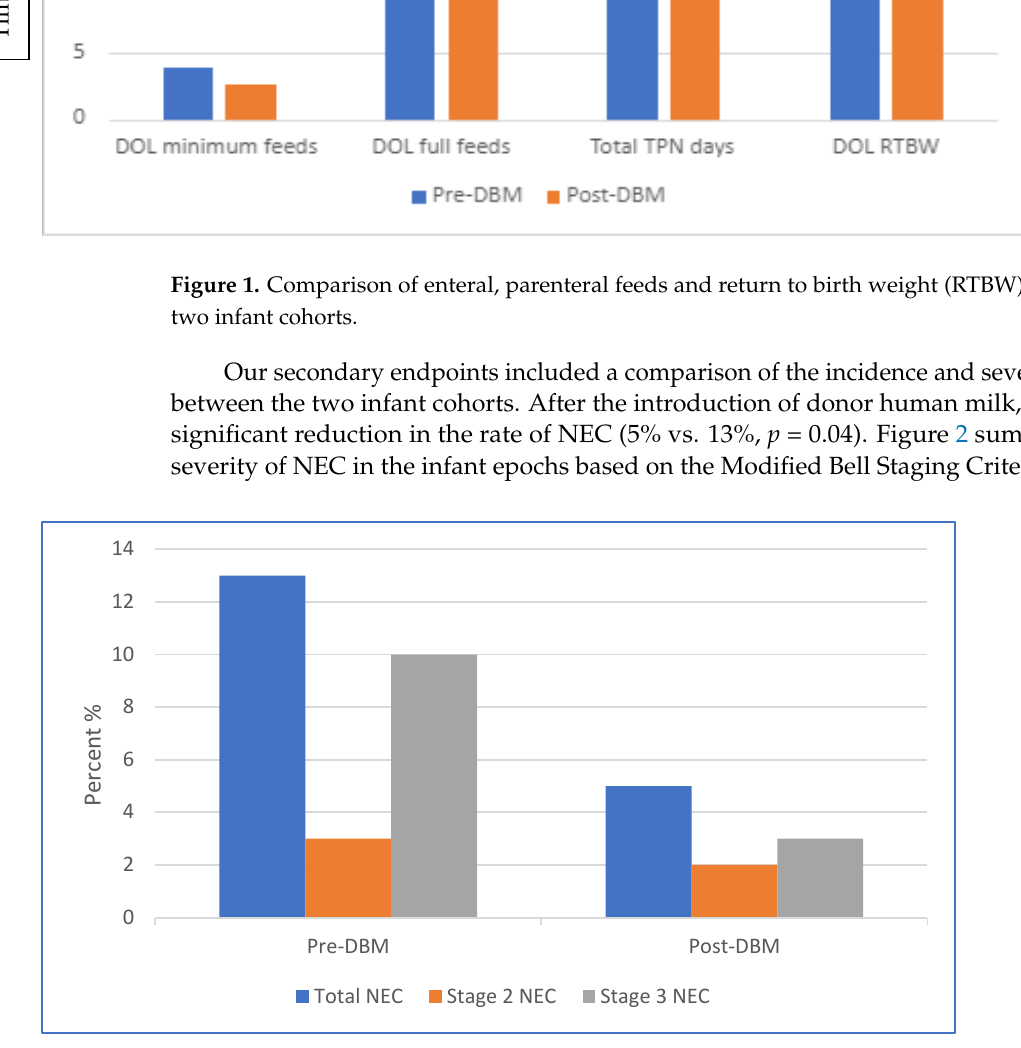
Figure 1. Comparison of enteral, parenteral feeds and return to birth weight (RTBW) between the two infant cohorts.